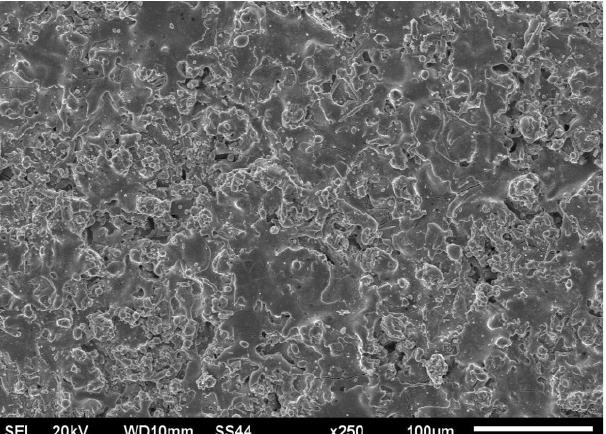
Figure 2. Cr 3 C 2 –NiCr coating surface microstructure (SSS after the APS process).